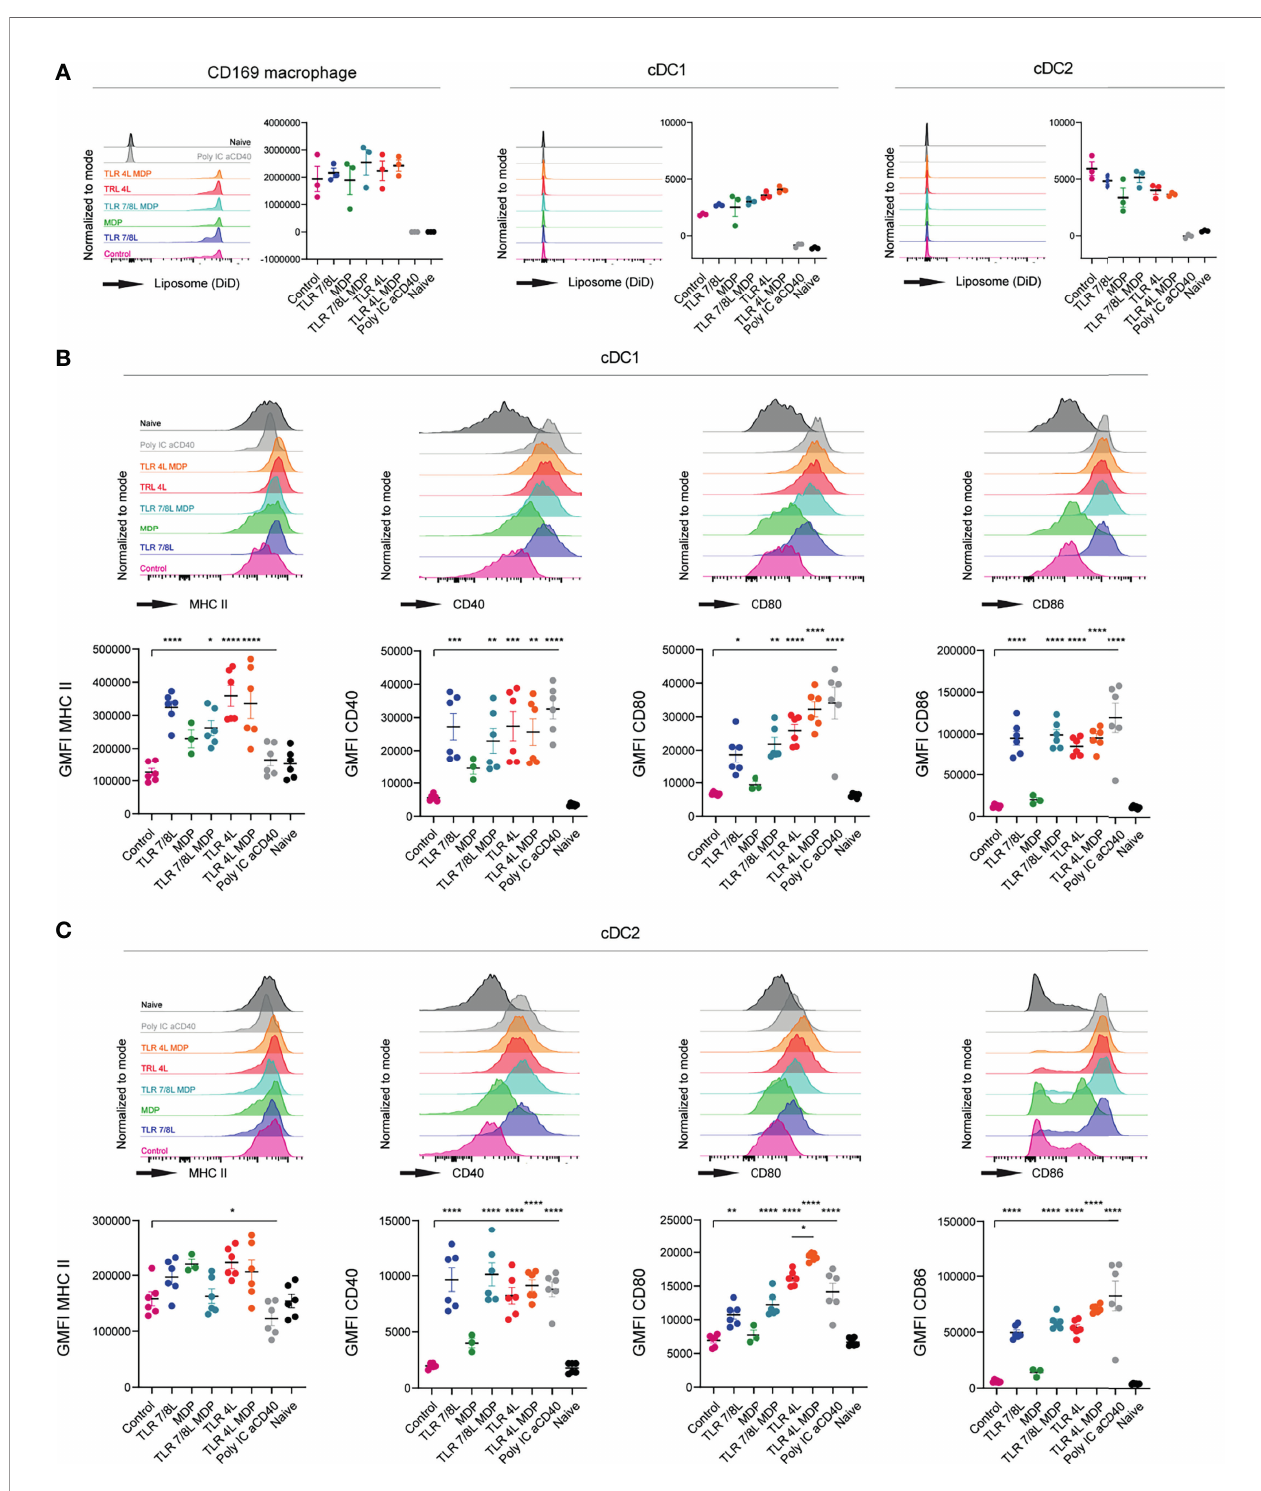
FIGURE 3 | TLRL-containing GM3 liposomes induce DC maturation in vivo and additional incorporation of MDP has no effect. (A – C) Mice were i.v. injected with different liposomal formulations, poly IC and aCD40 antibody as positive control, or left uninjected (naive). 16h after injection, spleens were collected and a single cell suspension was used for fl ow cytometry staining and analysis. Indicated are representative histogram overlays and the quanti fi ed DiD-signal as average ± SEM ( n = 3), representative of two independent experiments (A) . Indicated are representative histogram overlays and quanti fi ed average ± SEM of maturation markers on cDC1 and cDC2 [ (B, C) , respectively] ( n = 3-6), data pooled from two independent experiments. *p < 0.05, **p <0.01, ***p < 0.005 and ****p <